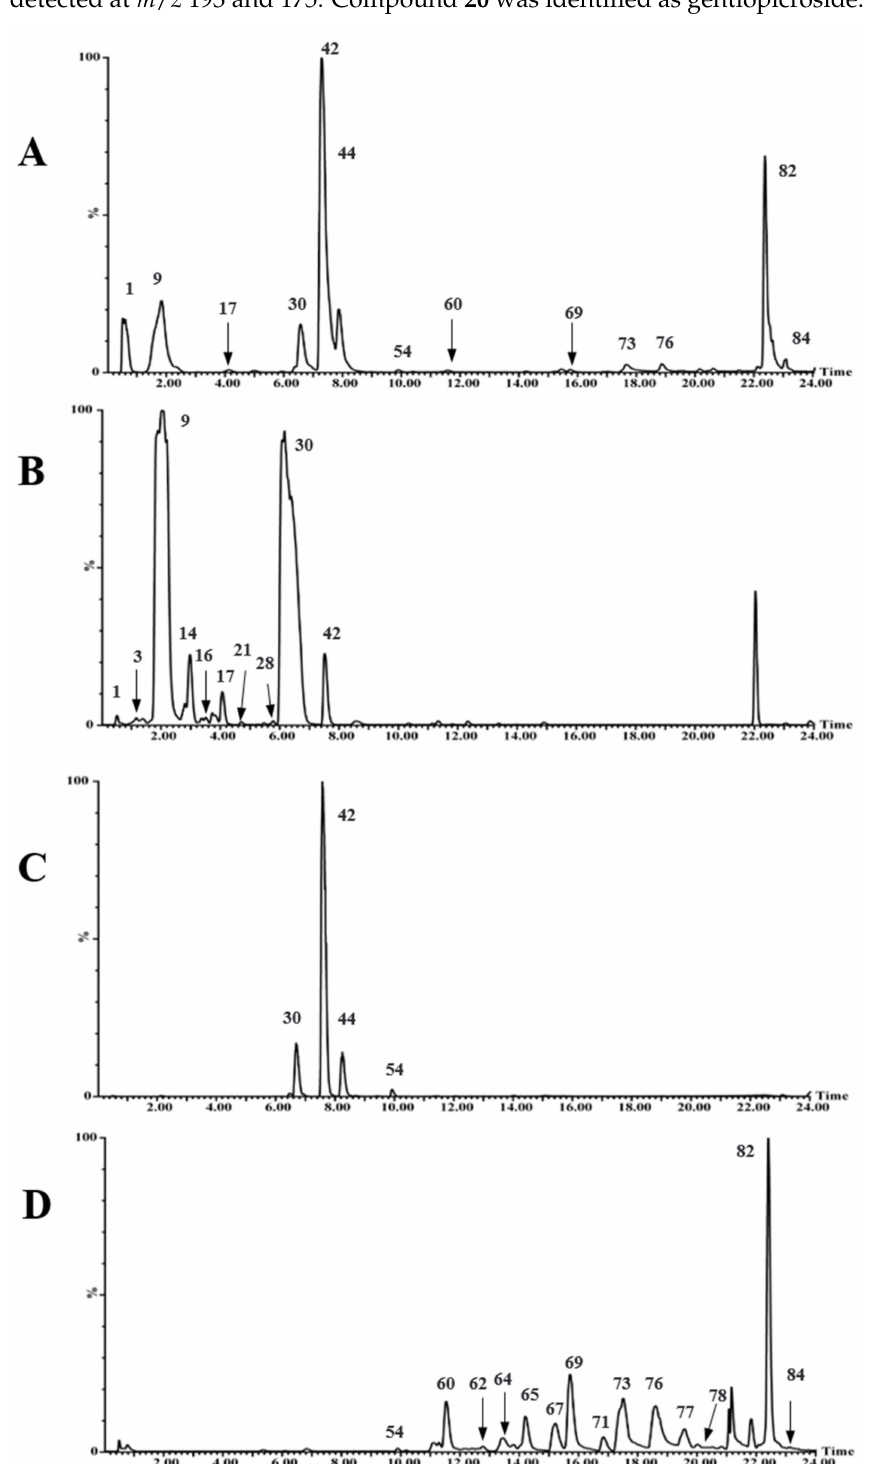
Figure 1. Base peak ion chromatograms of crude extract and each eluted fraction of PAL obtained by UHPLC-Q-TOF MS in the negative ion mode: ( A ) crude extract of PAL; ( B ) P1; ( C ) P2; ( D )